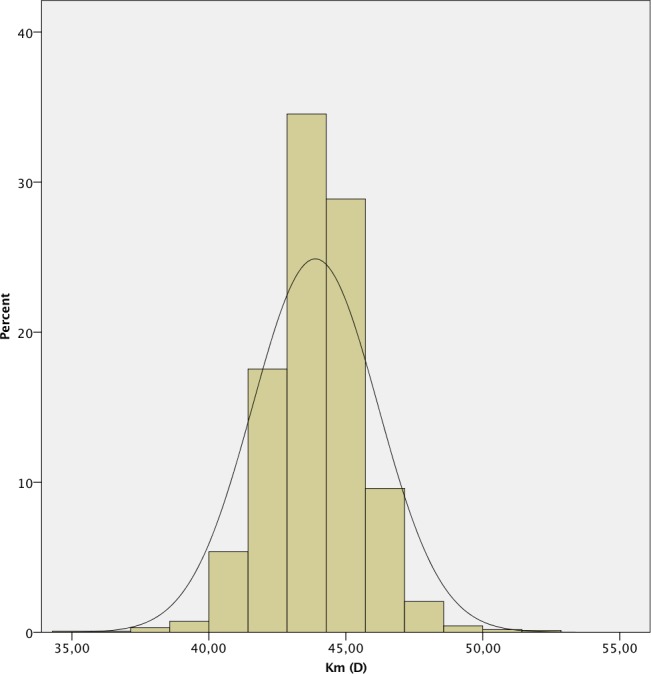
Histogram of mean keratometry (K) of the study population.